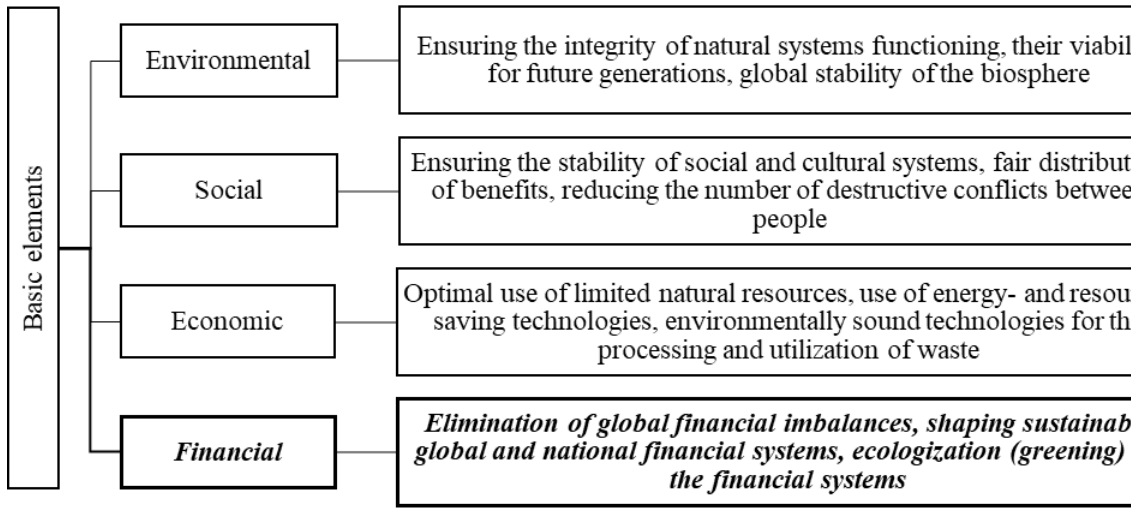
Fig. 4. Modern approach to basic elements of the sustainable development